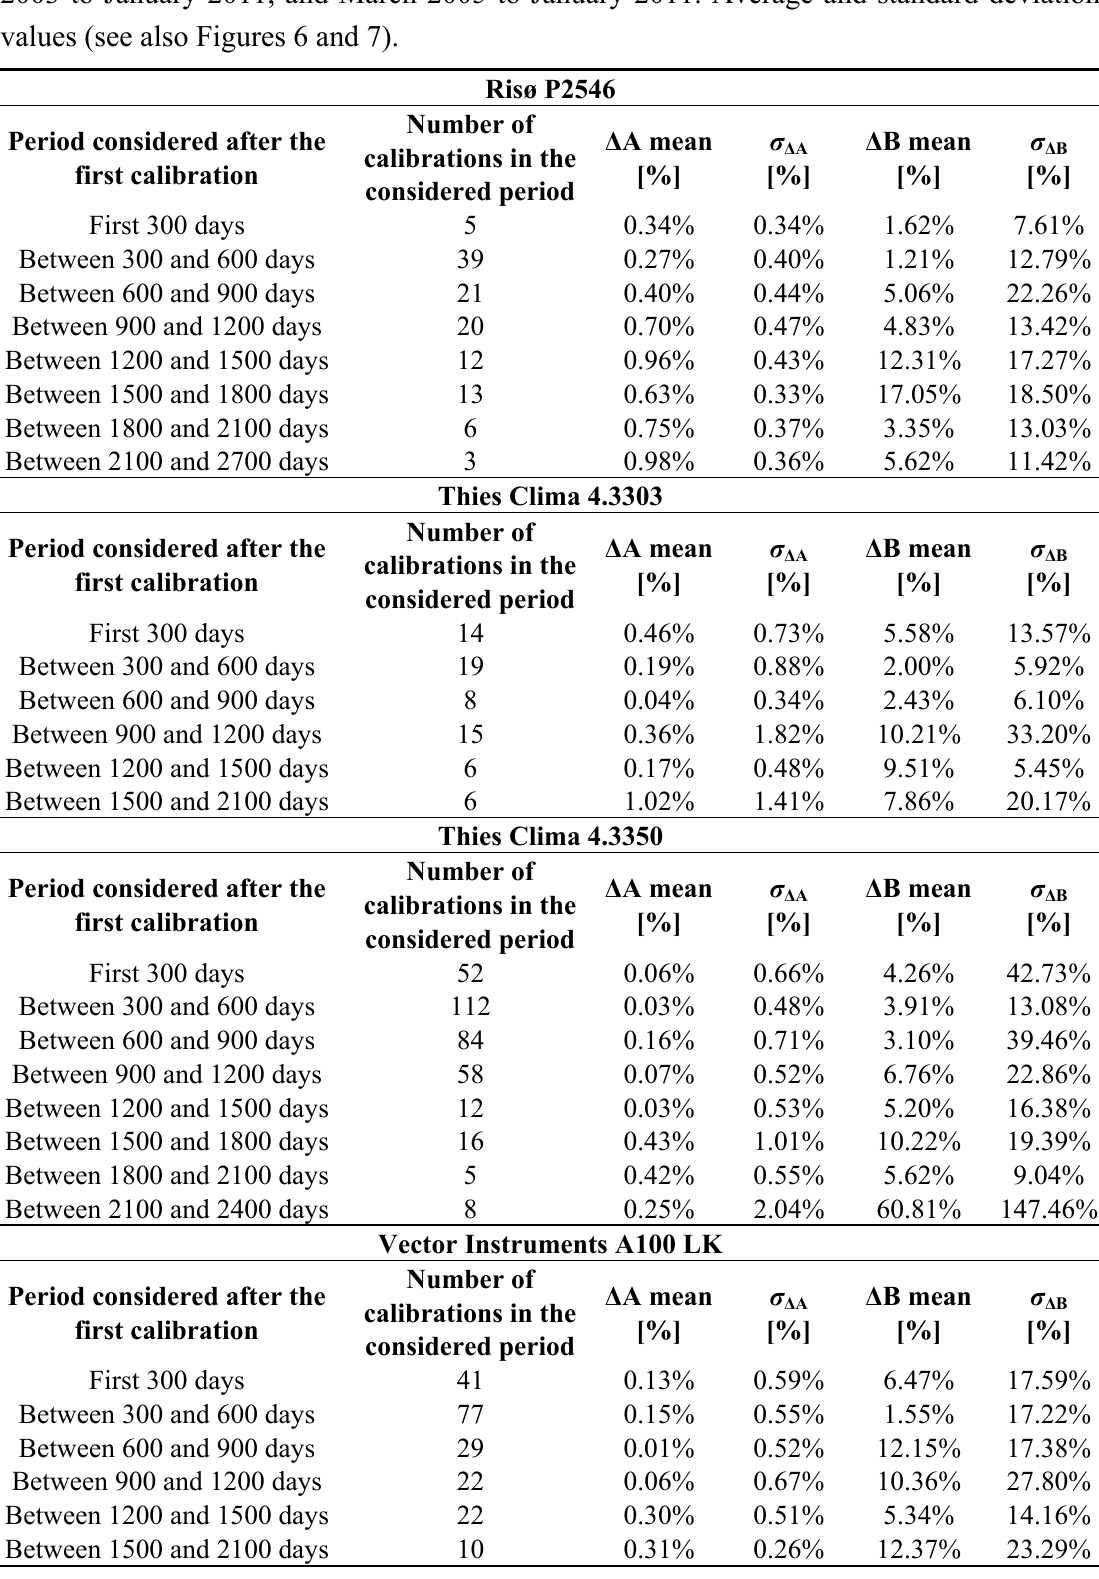
Table 6. Percentage variation of coefficients A and B from the initial calibration each 300 days, corresponding to Risø P2546, Thies Clima 4.3303, Thies Clima 4.3350, and Vector Instruments A100 LK anemometers respectively calibrated at the IDR/UPM